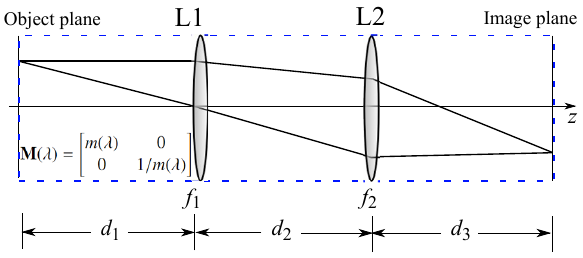
Figure 1. The transformation system, which is described within the blue dashed lines by the ray-transfer matrix M . The lenses L1 and L2 are refractive or di ff ractive thin lenses with respective focal lengths f 1 and f 2 . The lenses are separated by distances d 1 , d 2 , and d 3 , which, together with the order of the lenses, specify the nature of the transformation. Adapted from